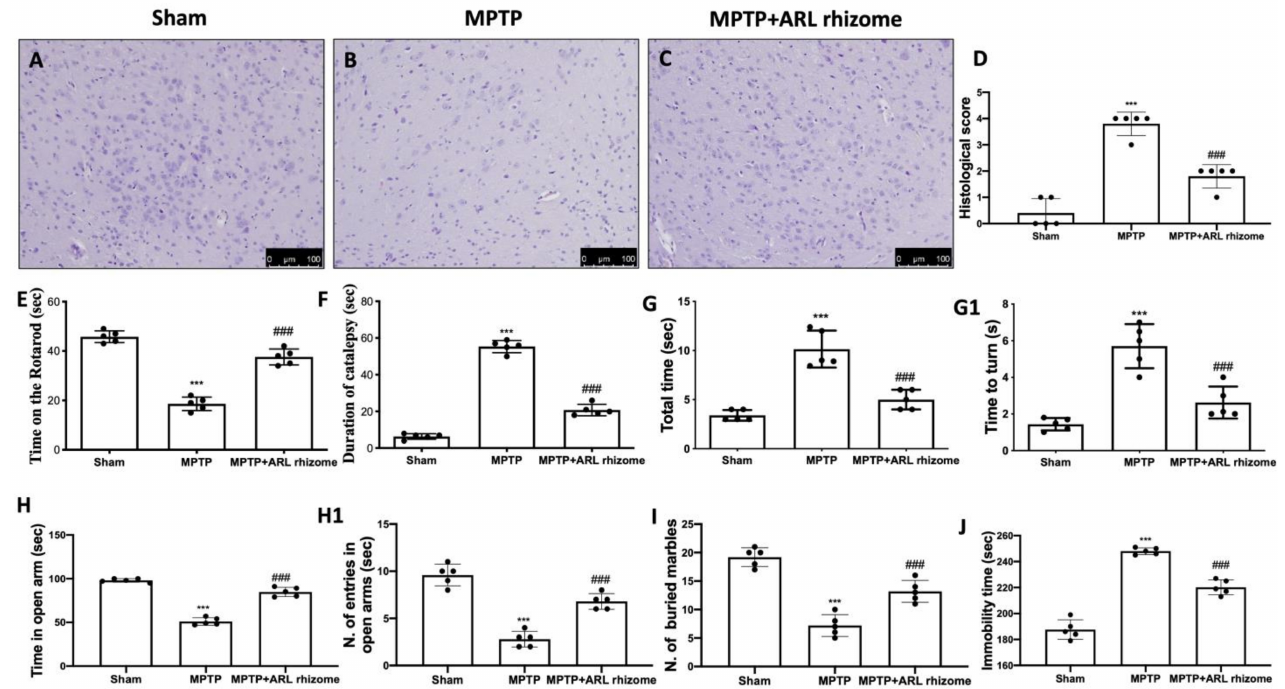
Figure 7. Effect of ARL rhizome on histological parameters and behavioral alterations in MPTP- lesioned mice. MPTP-injured mice were characterized by nigrostriatal dopaminergic degeneration, which translated into neuronal cell loss in the midbrain ( B ) with respect to physiological neuronal cell structure observed in control mice ( A ), ARL rhizome treatment reduced alteration of the dopaminergic tract, mitigating neuronal cell loss ( C ). See histological score ( D ). Motor function was assessed using RT ( E ), Catalepsy test ( F ) and a Pole test ( G , G1 ). The behavioral analysis of non-motor symptoms was assessed using EPM test ( H , H1 ), MBT ( I ) and TST ( J ). The data are representative of at least three independent experiments and are expressed as the mean ± SD of five mice for each group. *** p < 0.001 vs. Sham; ### p < 0.001 vs.